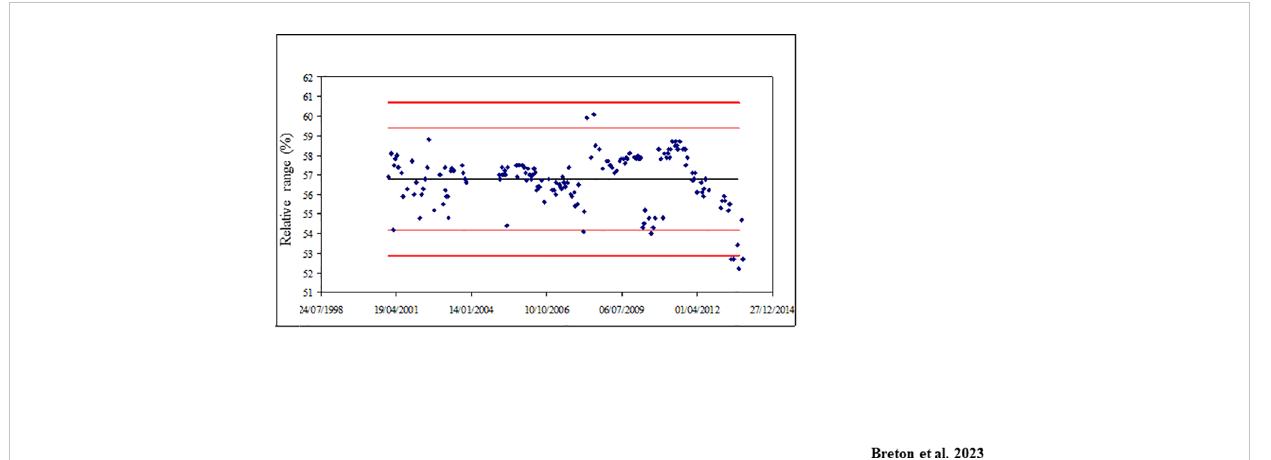
FIGURE 3 Within-laboratory control: example of control chart based on Nordtest TR 569 (2007) for ensuring that the data are of good quality and the measurement process is statistically stable. Black line: the central line; thin red line: the warming limits; and thick red line: the action limits. The data value is considered in control if it is within the warming limits or if the value is between the warming and action limits but the two previous ones are within the warming limits. In this case, data are considered of good quality. The data value is considered outside control if the data value is outside action limits or between the warming and action limits and at least one of the two previous values are between warming and action limits too. In this case, measurement analysis must be made again once the problems are resolved if possible. The data value is considered in control but must be scrupulously monitored if the last 7 previous values exhibit a trend or 10 of the last 11 control values are on the same side and far from the central